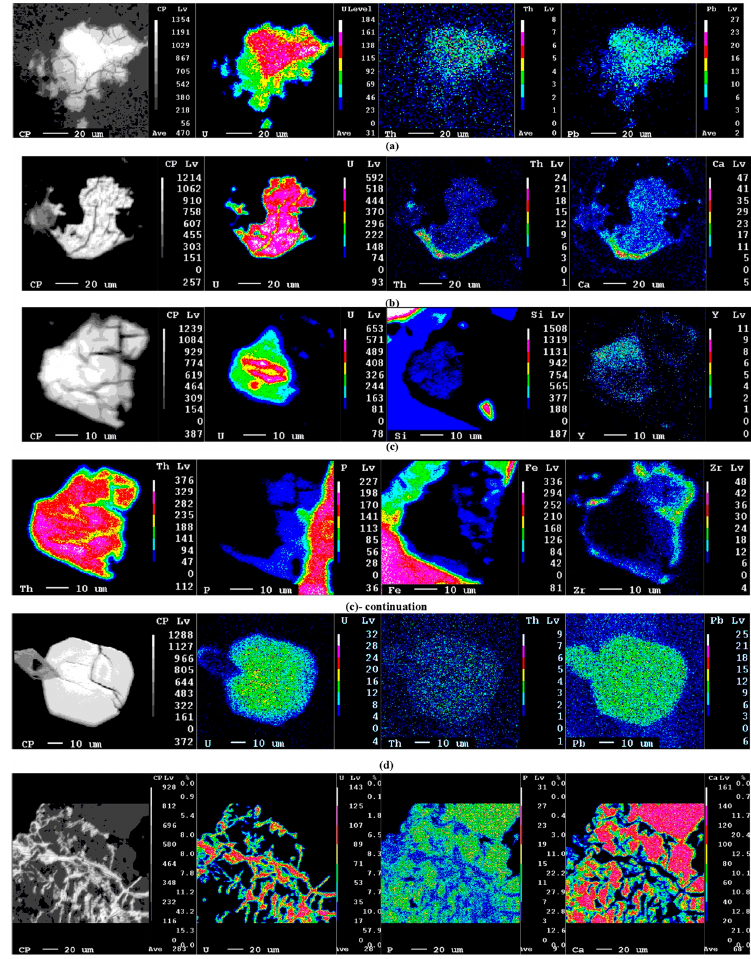
Figure 4. X-ray element maps, obtained by electron microprobe, of minerals from altered granite and hydrothermal quartz veins. ( a ) Altered crystal of uraninite from altered granite. ( b ) Altered crystal of coffinite from altered granite. ( c ) Altered crystal of thorite from altered granite. ( d ) Altered crystal of xenotime from altered granite. ( e ) Crystal of apatite from altered granite replaced by (meta)saleeite from hydrothermal quartz veins.